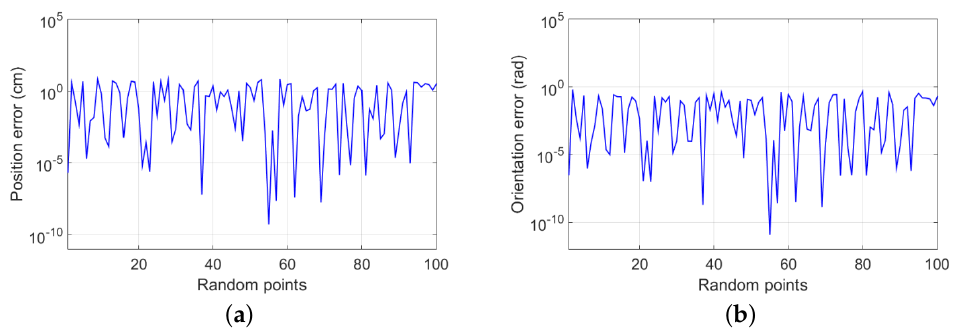
Figure 6. ( a ) Position error of each randomly generated point, ( b ) orientation error of each randomly generated point.